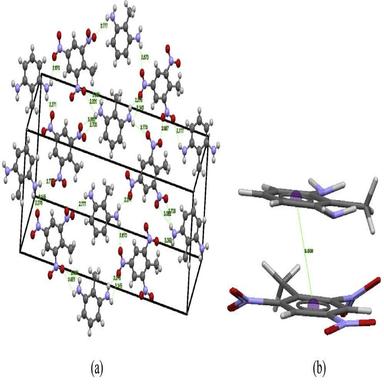
Intermolecular interaction between TNT and 2,6-diaminotoluene: (a) amine-nitro, (b) P-P stacking.